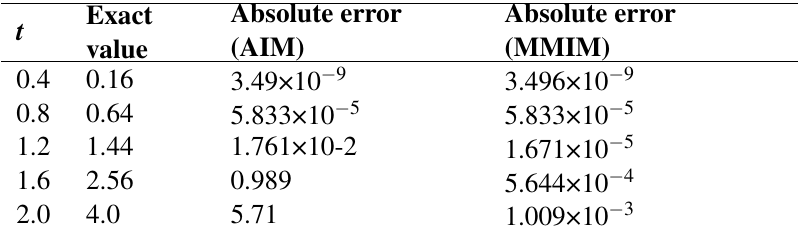
Table 1 Comparative study of AIM and MMIM